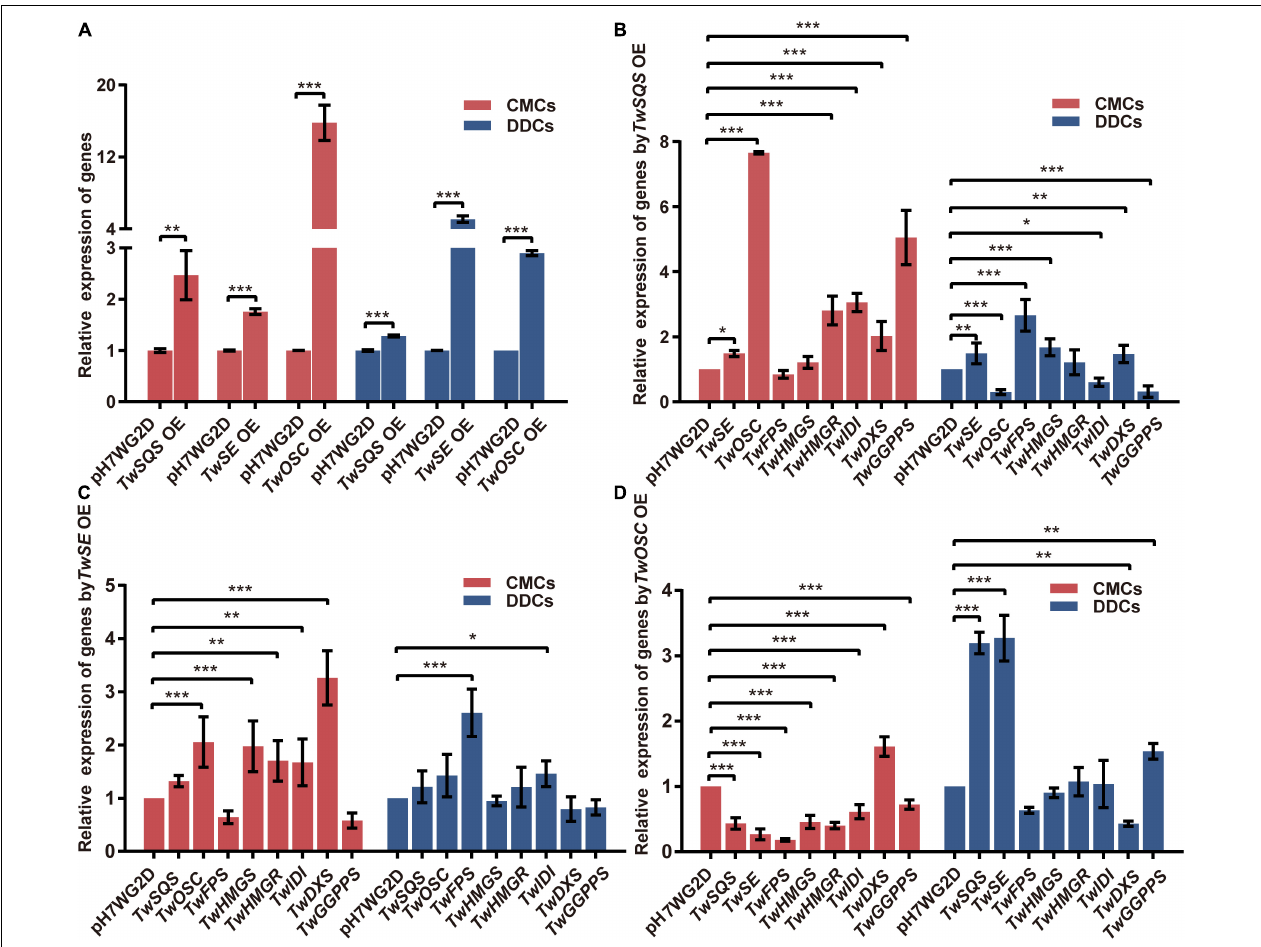
FIGURE 4 | Relative expression analysis of related genes involved in terpenoid biosynthetic pathway in Tripterygium wilfordii CMCs and DDCs after overexpression of TwSQS , TwSE , and TwOSC . (A) Relative expression levels of TwSQS , TwSE , and TwOSC. (B) Relative expression levels of related genes in terpenoid biosynthetic pathway after TwSQS overexpression. (C) Relative expression levels of related genes in terpenoid biosynthetic pathway after TwSE overexpression. (D) Relative expression levels of related genes in terpenoid biosynthetic pathway after TwOSC overexpression. OE, overexpression. The data are summarized as means ± standard deviation. * p < 0.05, ** p < 0.01, and *** p < 0.001, n = 5. Student’s t